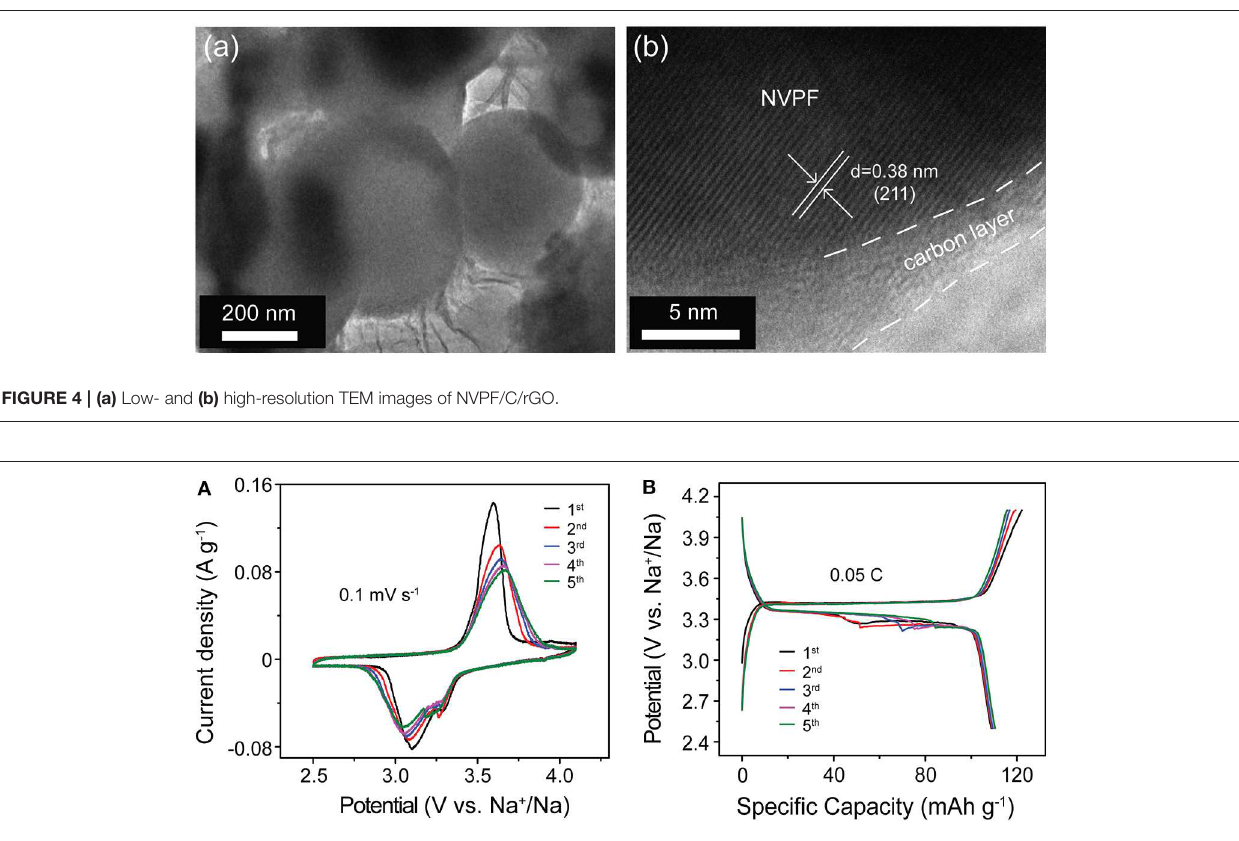
Frontiers in Energy Research |